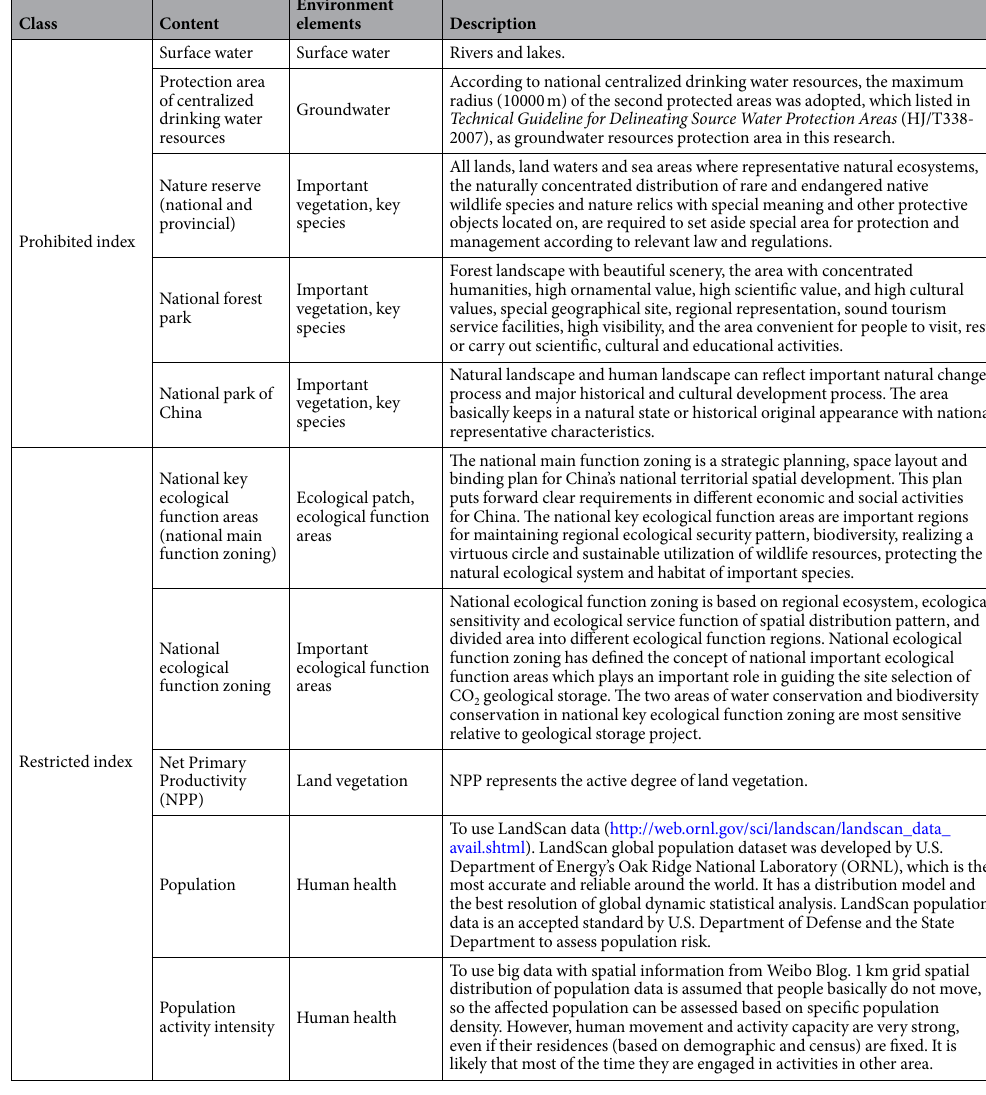
Table 2. Evaluation index system for environmental risks and environmental impacts of CO 2 geological